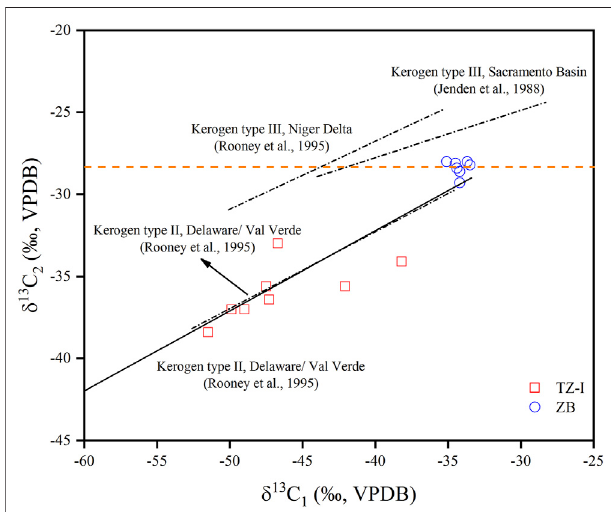
FIGURE 5 | δ 13 C 1 verse δ 13 C 2 cross plot of natural gases from TZ-I and ZB gas fi elds. Also shown are the maturity trend of type II kerogen (Rooney et al., 1995; Tilley and Muehlenbachs, 2013) and type III kerogen (Jenden et al., 1988; Rooney et al., 1995).